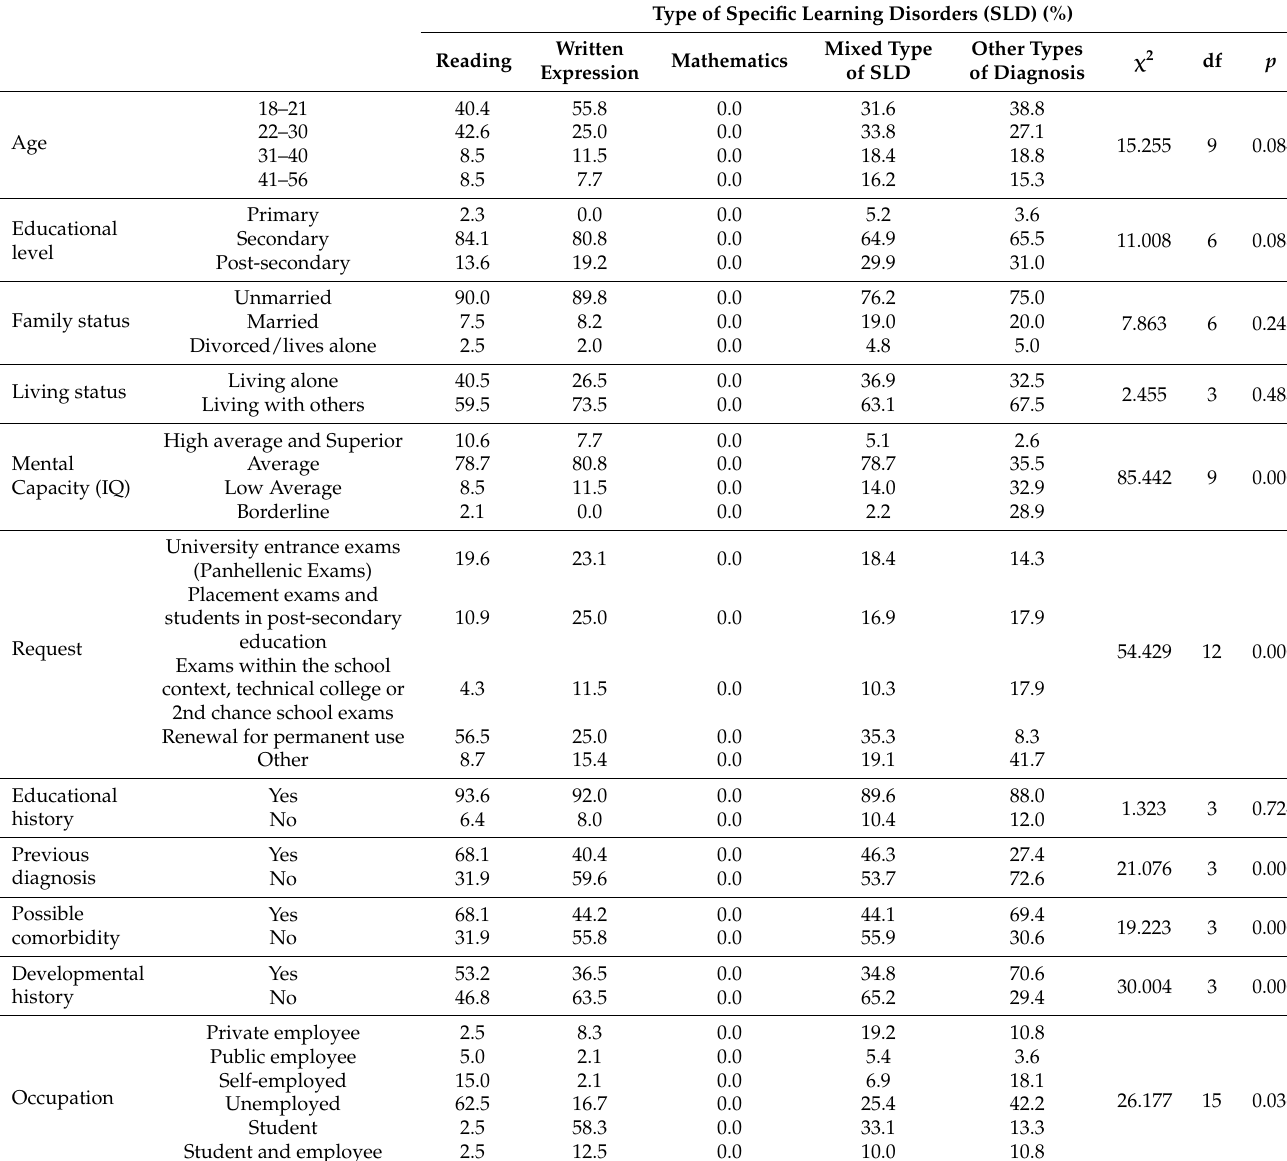
Table A3. Relationship of the Types of Specific Learning Disorders (SLD) diagnosed in the assessed adults with the other